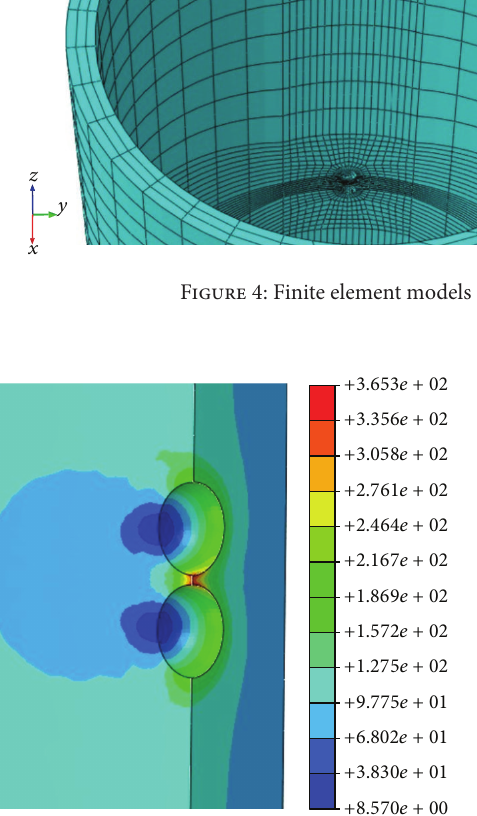
Figure 5: Cross section stress distribution of double cavities ( 𝐿/𝑅 = 2.2 ).